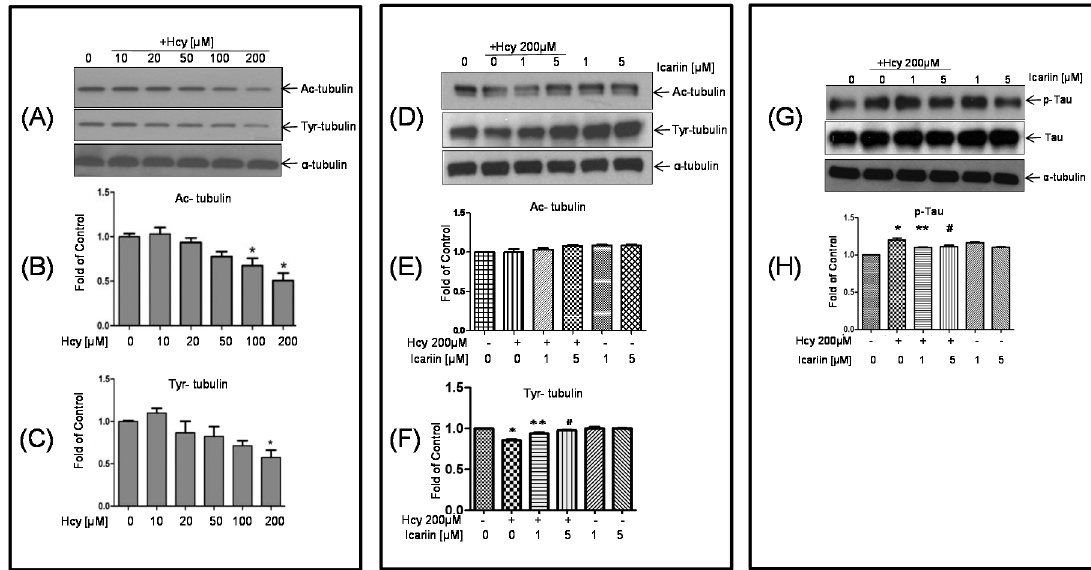
Figure 3. Icariin restored the Hcy-reduced acetylation and phosphorylation of tubulin in cultured neuronal cells. ( A – F ): Primary cortical neuronal cultures were treated with 200 μ M Hcy for 48 h. For the co-treatment, cells were pretreated with icariin for 1 h, before incubating with Hcy for 48 h. The treated cells were subjected for western blot analyses and quantified for the detection of Ac- and Tyr-tubulin with anti-Ac- α -tubulin and anti-tyr-antibodies. ( G – H ) Western blot analysis for the detection of p-tau and total tau with anti-p-tau and anti-tau antibodies. Cells were treated 200 α M Hcy alone for 2 h. For the co-treatment, cells were pretreated with icariin for 1 h, followed by co-incubation with Hcy for another 2 h. α -tubulin was used as internal control. Data represent mean ± SE from at least three independent experiments and was quantified using densitometry. *: p < 0.05 compared to control. ** and #: p < 0.05 compared to cultures treated with 200 μ M Hcy. “+” and “-”: with and without the compound.